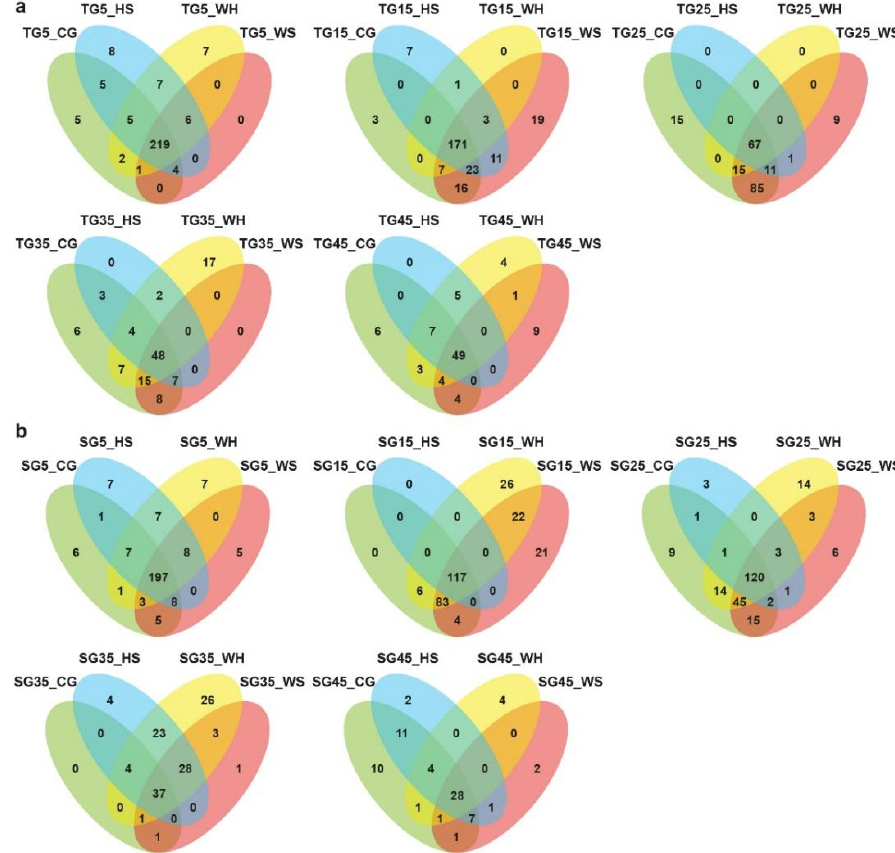
Figure 1. Venn diagrams showing the distribution of microRNAs across different small RNA (sRNA) sequencing libraries. ( a ) The distribution of microRNAs across four treatments at each developmental time-point in DBA Aurora libraries. ( b ) The distribution of microRNAs across four treatments at each developmental time-point in L6 libraries. TG, libraries made from developing grains of the stress-tolerant genotype DBA Aurora. SG, libraries made from developing grains of the stress-sensitive genotype L6. DPA values of 5, 15, 25, 35, and 45 indicate treatment time-points (days post anthesis). CG, control group. WS, water deficit stress group. HS, heat stress group. WH, water deficit plus heat stress group.